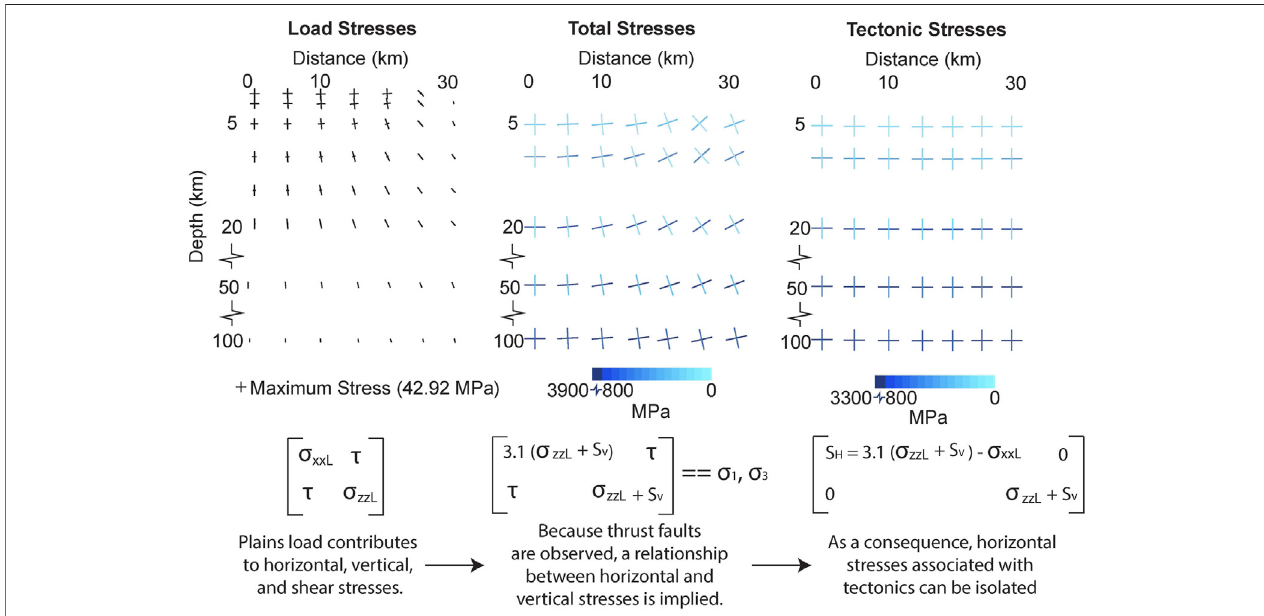
FIGURE 4 | These graphs depict the maximum and minimum principal stresses associated with the (left) load of a 50 km-wide, 4 km-deep section of thick northern smooth plains deposits, (center) superimposed tectonic and load stresses, and (right) tectonic stresses necessary to produce thrust faults in the stress contextofthesmoothplains.Onlytherighthalfoftheaffectedspaceisshown.Stresstensorsassociatedwitheachscenarioarealsoprovidedwhere σ xxL , σ zzL ,and τ are horizontal,vertical,and shearstressesassociated withtheload,S v and S H aretheverticaland horizontalstresses associatedwiththrustfaulting,and σ 1 and σ 3 are the total principal